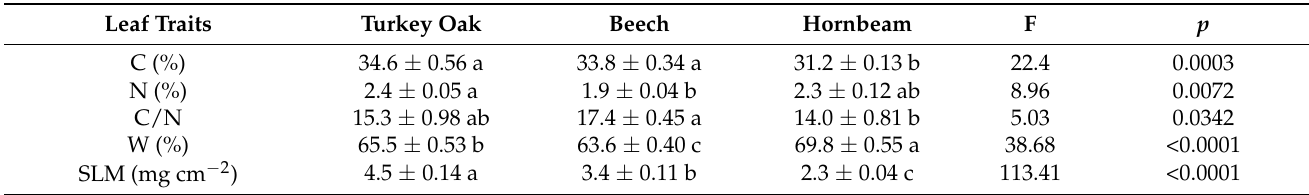
Table 2. Leaf traits (mean ± SE) of the different tree species (C—carbon content; N—nitrogen content; C/N ratio; W—water content; SLM—specific leaf mass) compared using one-way ANOVA (F and p values) and Tukey HSD tests. Means in the same row followed by different letters differ significantly ( p <